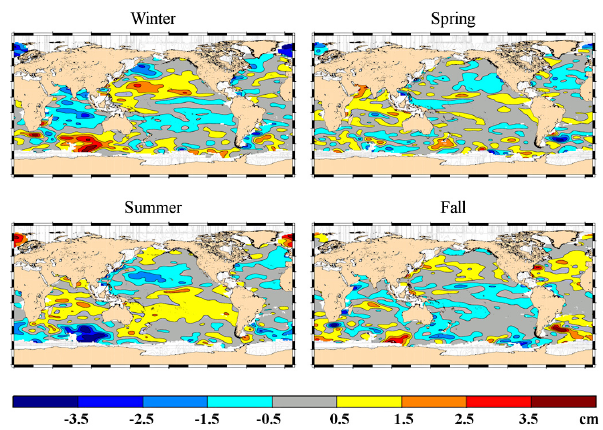
Fig. 7. Seasonal variation of the differences between SLA and DHA. Boxes with less than 10 observations are